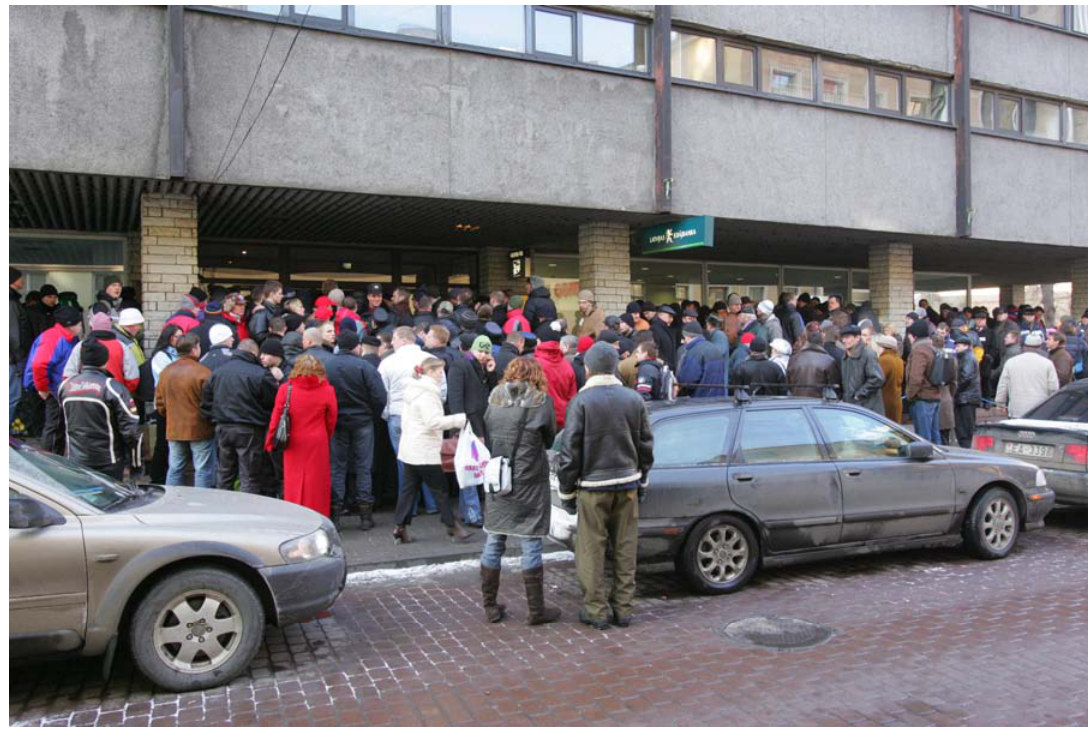
Fig. 1. Latvia, Riga, 20 March 2006. A disturbance arose at the doors of the main office of Latvian Investment and De- velopment Agency. The reason was an announcement that money shall be allocated according to the order in which projects are submitted. Queues were regulated by no-one, hence, three alternative lines were formed; friction between these lines caused the blockade of all the institutions and enterprises located in the same building with the main office of Latvian Investment and Development Agency. Photo –Aigars Egīte, Neatkarīgā